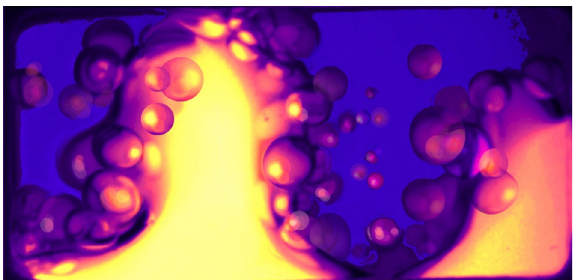
Fig. 3 Interfacial dynamics of fl uids in microgravity. Complex interfacial dynamics with FC-40 and 20 cSt silicone oil vibrated at 50 Hz in microgravity 50